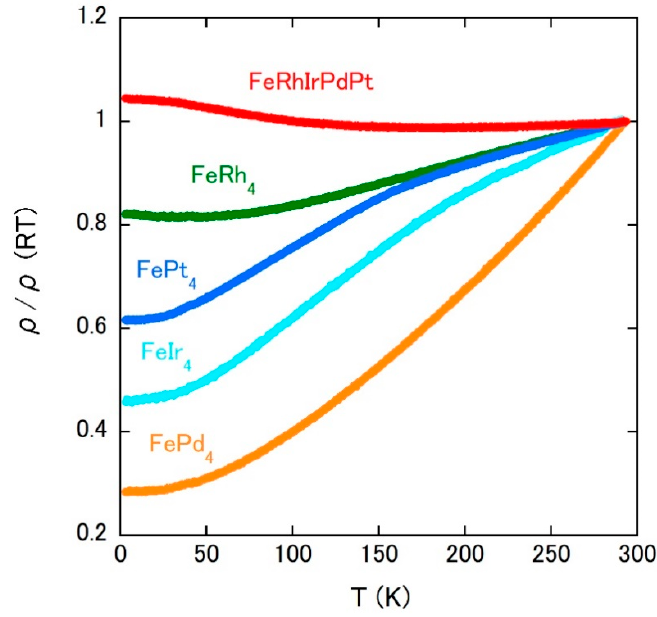
Figure 8. Temperature dependences of electrical resistivity of FeRh 4 , FeIr 4 , FePd 4 , FePt 4 , and